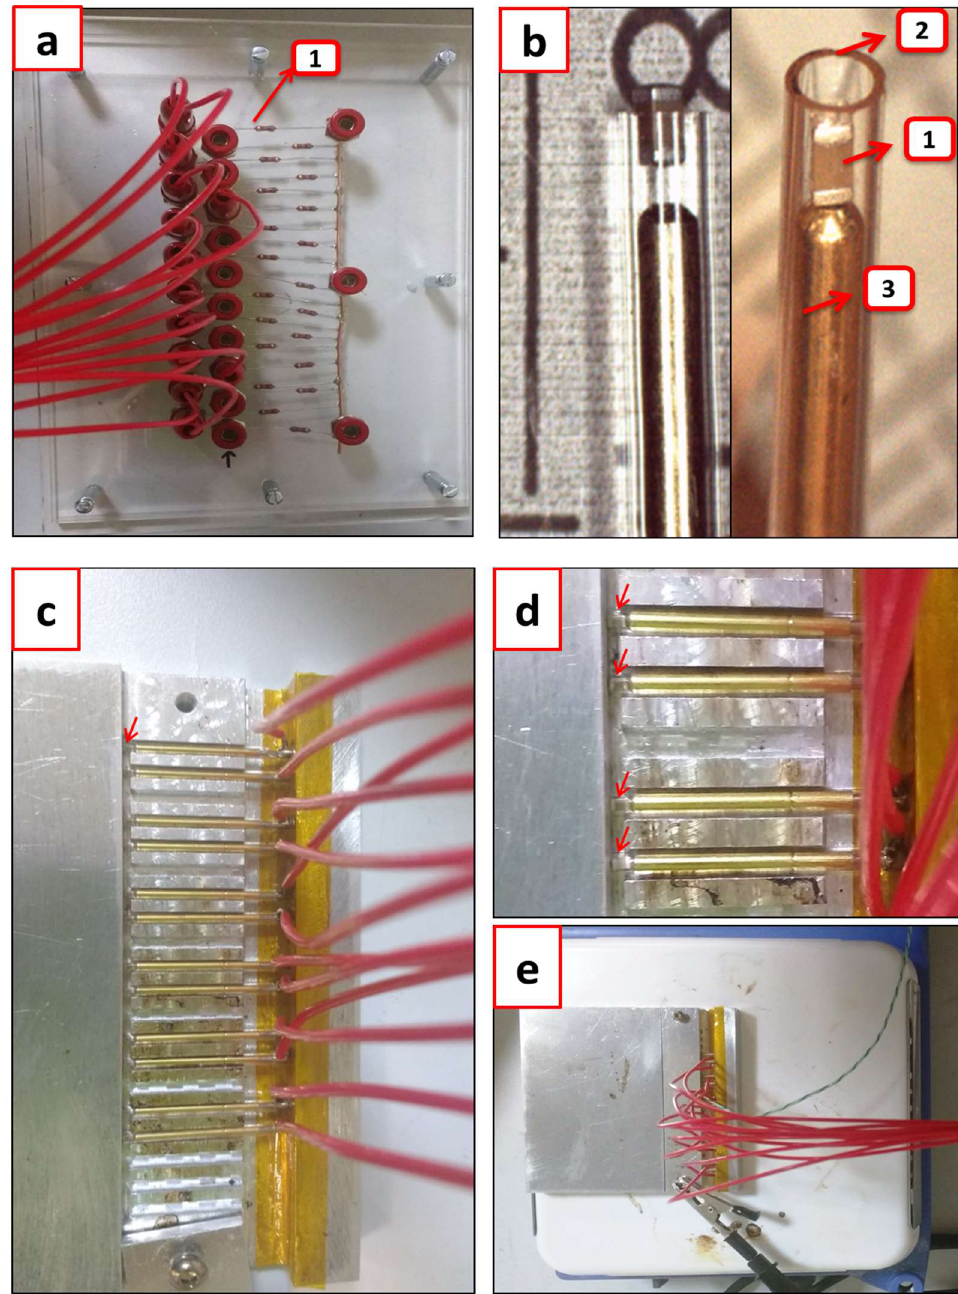
Figure 4. ( a ) Plate with the protective resistors (1) connected in series with each sample; ( b ) View of an MLCC (1) inside the glass capillary (2) together with a spring (3); ( c ) View of the assembled connections (cables + springs) together with the MLCCs in the metallic plate interior canals; ( d ) Enlarged view of the interior of the cell, where red arrows highlight the samples inside of a glass capillary; ( e ) View of the closed cell (with the samples inside) above the heating plate ready for the test.